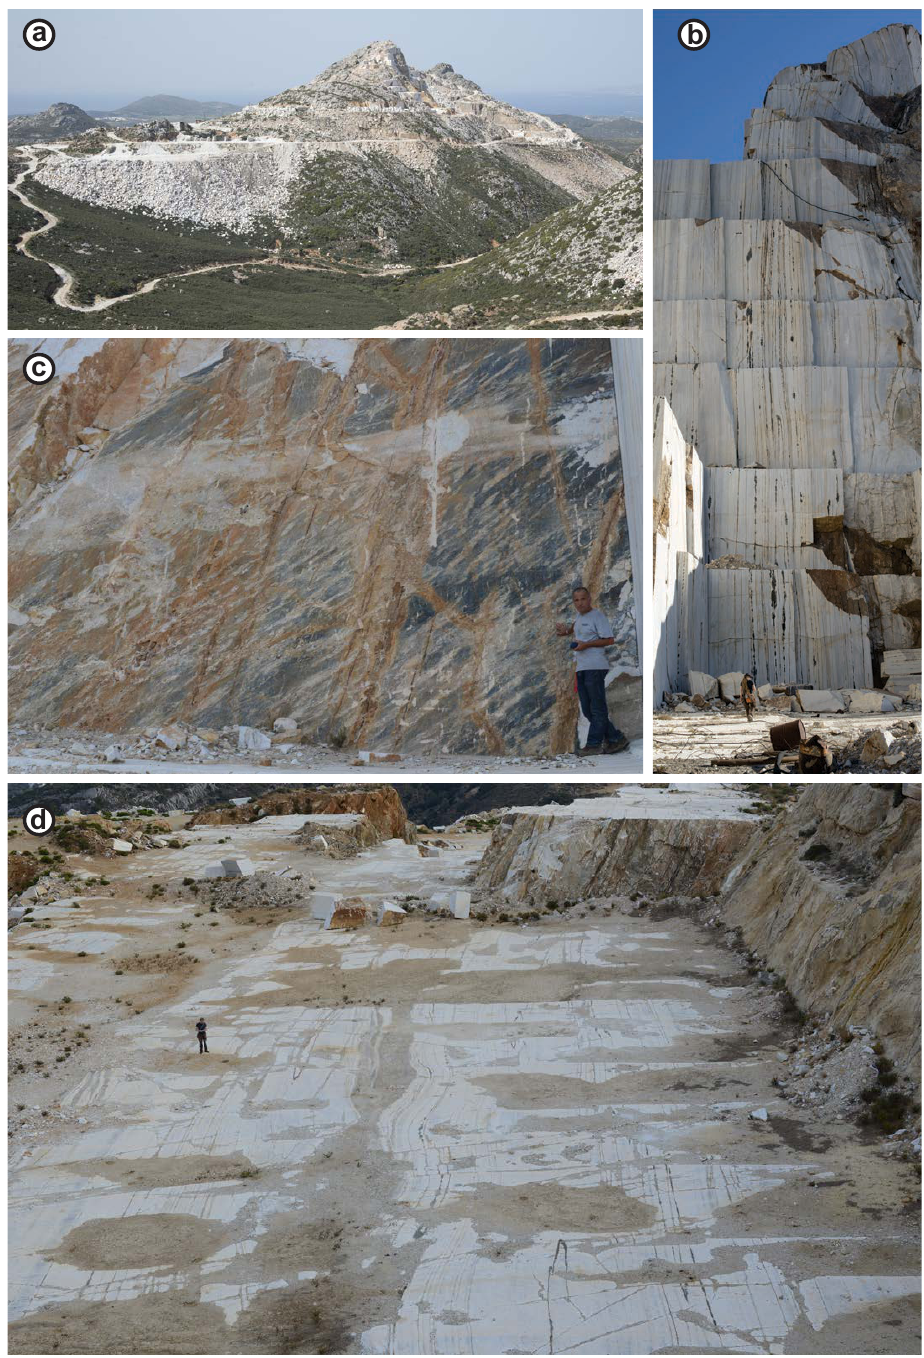
Figure 3. Excellent outcrop conditions in marble quarries allow for detailed observation of the boudinaged amphibolite at vertical and horizontal faces. All images contain a geologist for scale. (a) View to the west on Mount Bolibas, hosting the largest quarry in the area (Location 16–29). (b) Inside the Bolibas quarry, view to the south. The subvertical N–S striking amphibolites can be followed over all soles of the quarry. This section exposes mostly pinch-and-swell boudins. (c) View to the west on an amphibolite surface (Location 31). Layer- parallel cuts like this are essential for age relationship observations and expose the subhorizontal necks of the lλ pinch-and-swell boudins, which are hard to identify in layer-normal cuts. (d) Recently abandoned quarry in the south of the field area (Location 32–35) exposing many folds, brittle boudins and a large boudinaged inclusion of schist across a football-field-sized horizontal surface.